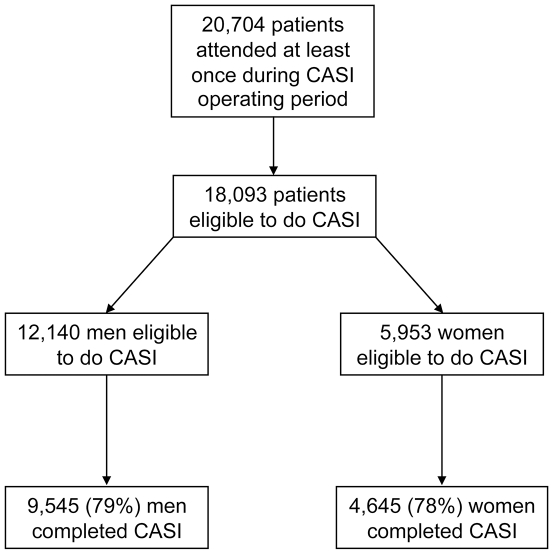
Diagram of patients attending the Melbourne Sexual Health Centre and those that were eligible and completed computer assisted self interviewing (CASI).